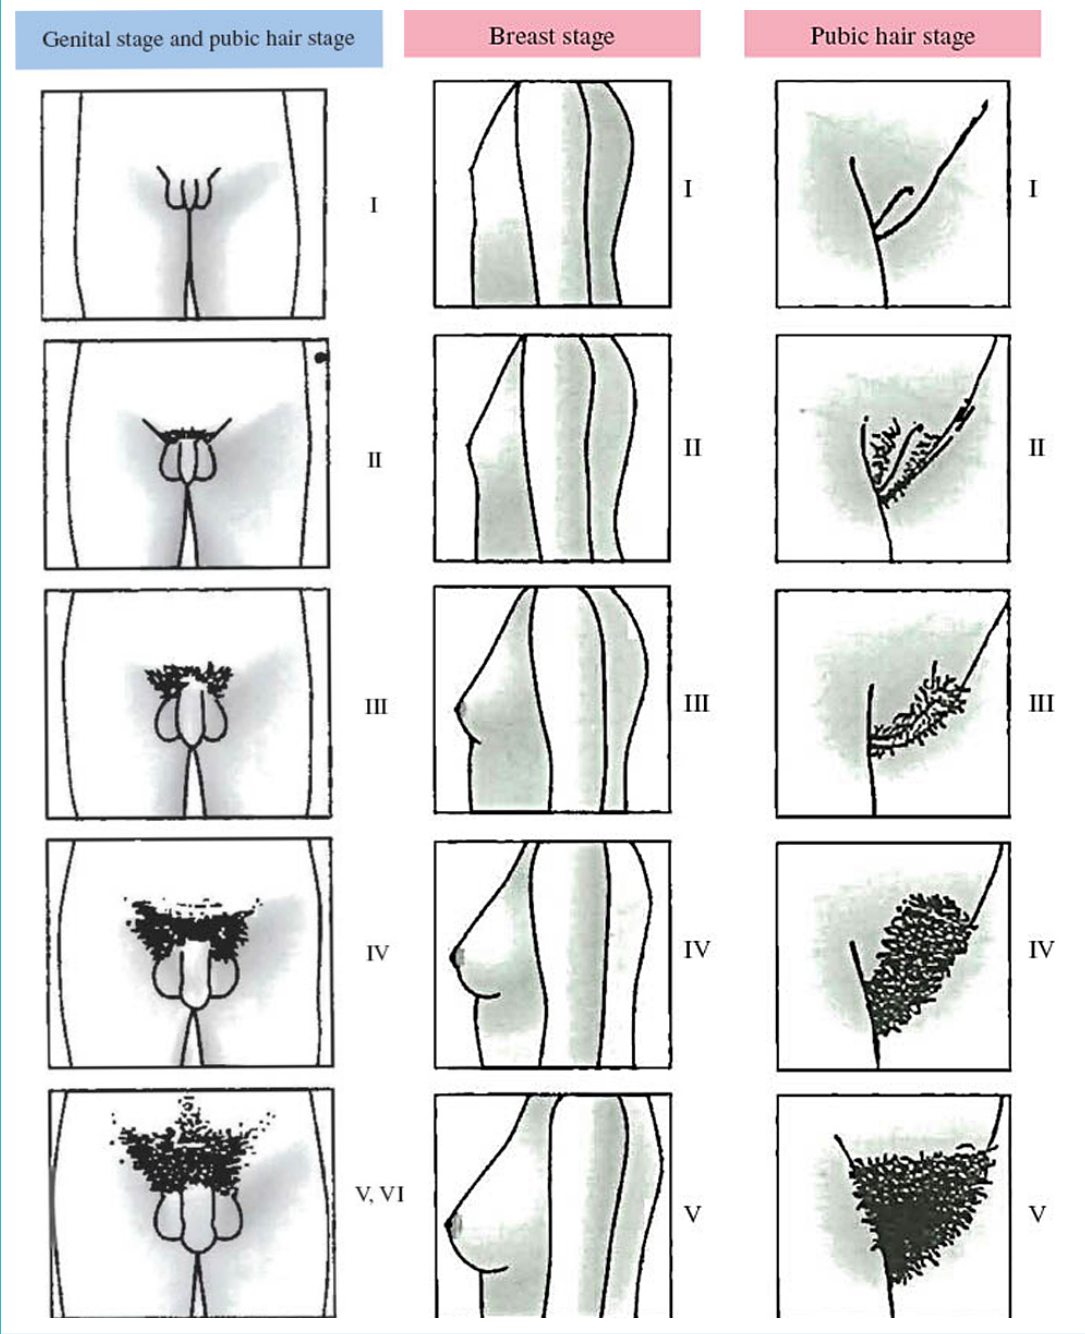
Figure 1: A schematic drawing of the five Tanner stages for girls and boys. From: Jaruratanasirikul S, Kreetapirom P, Tassanakijpanich N, Sriplung H. Reliability of pubertal maturation self-assessment in a school-based survey. J Pediatr Endocrinol Metab. 2015;28(3-4):367-74, reprinted with